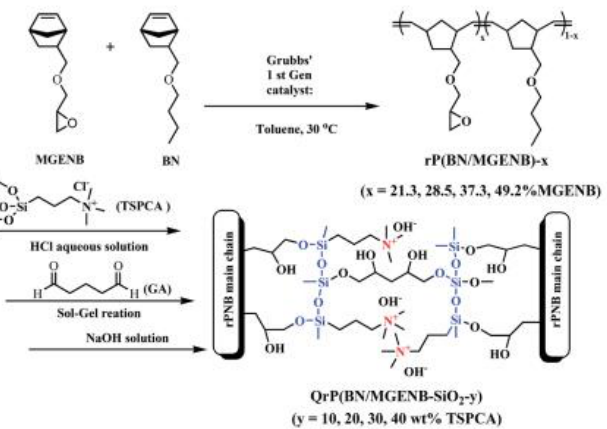
Figure 6. Schematic synthesis of polynorbornene based AEM. Reproduced from Reference [80] with permission from the Royal Society of Chemistry.